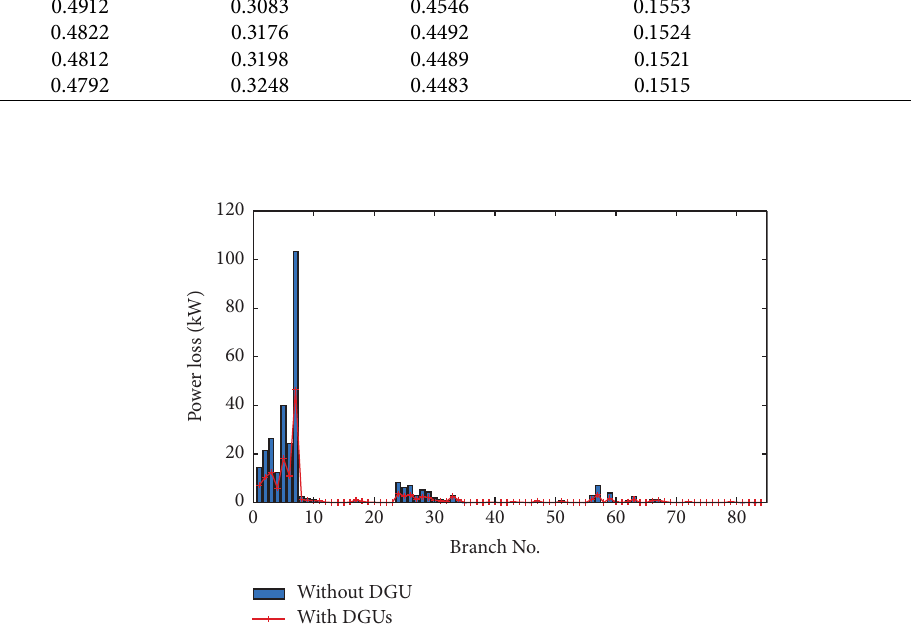
Figure 18: Power loss on distribution lines in IEEE 85-bus radial distribution system before and after placing